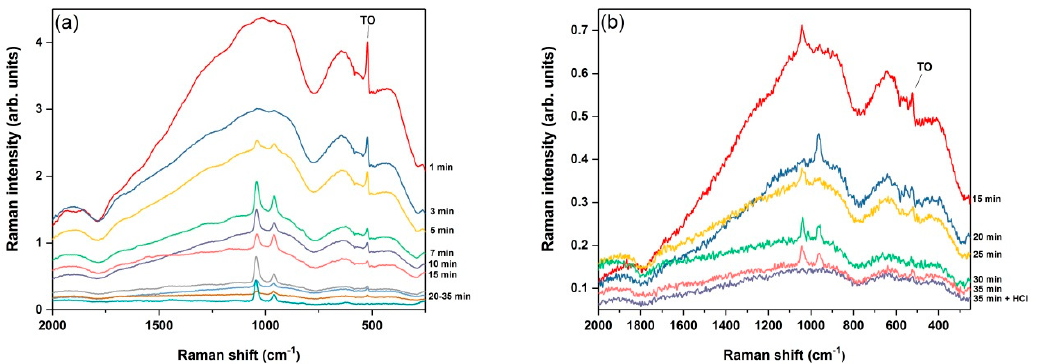
Figure 2. Comparison of FT-Raman spectra of pSi on top of a highly doped cSi substrate immersed in 10 − 2 AgNO 3 for different deposition times: ( a ) 1–35 min (50 scans), ( b ) 15–35 min (10 scans).